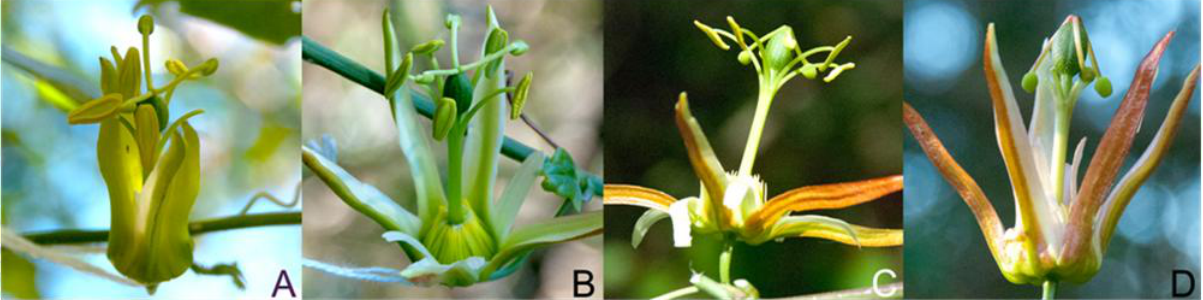
F IGURE 1. Anthesis pattern of Passiflora herbertiana over five days. (A) Onset of anthesis: Sepals open 1-2 cm in the afternoon, styles initially held at ca. 20˚ angle from androgynophore. (B) Next morning: perianth begins to open; anthers start to dehisce, styles will eventually become level with stamens. (C) 48-72 hours: perianth becomes fully expanded; the styles continue descent downward. (D) Last day of anthesis (stamens removed): perianth begins to close; styles fully extended downward, eventually curling around